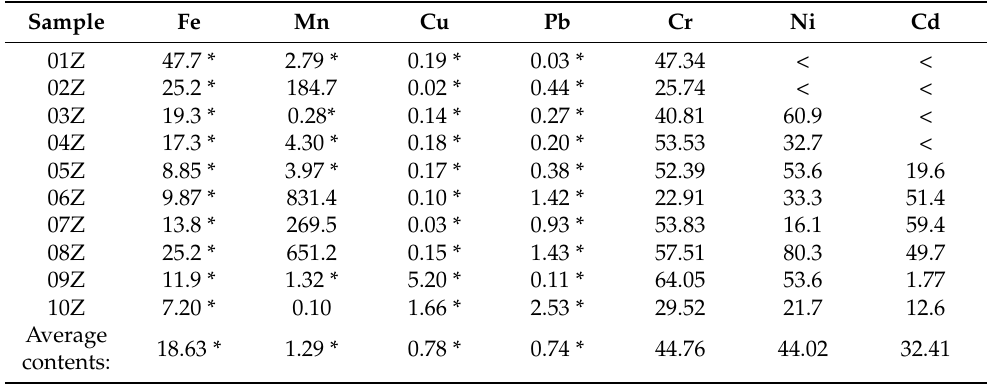
Figure 6. Backscattered electron (BSE) microphotographs showing the structure of the slag and the phases present: iron oxides and carbonate needles ( A ), copper, zinc and iron sulfides ( B ), gypsum crystals ( C ) and iron and zinc alloys ( D ). Table 1. Results of chemical analysis of slag samples: content in [ppm] or in [wt. %] of determined *.